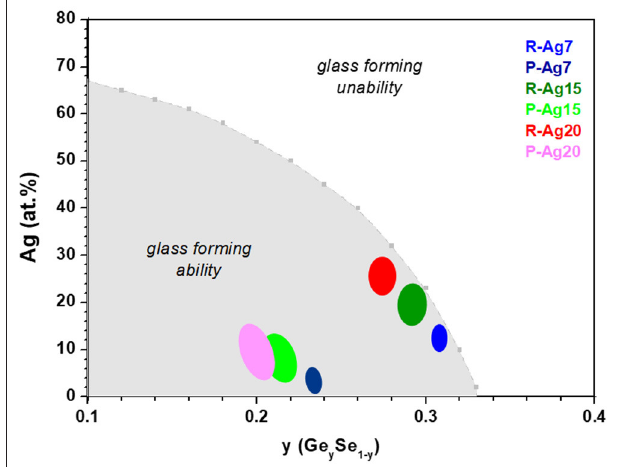
FIGURE 9 | Indentation modulus differences 1 M R − P predicted as a function of 1 x ′ x ′′ in the form of several linear curves each one corresponding to possible values of 1 z ′ z ′′ . Horizontal lines correspond to experimental 1 M R − P for Ag7, Ag15, and Ag20.